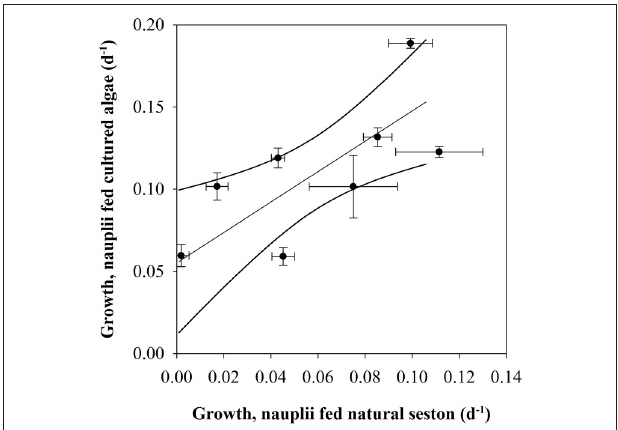
FIGURE 6 | Growth in nauplii fed natural seston (d − 1 ) vs. nauplii fed cultured microalgae (d − 1 ). Dots indicate average, error bars standard error. Lines indicate linear regression line with 95% confidence interval.